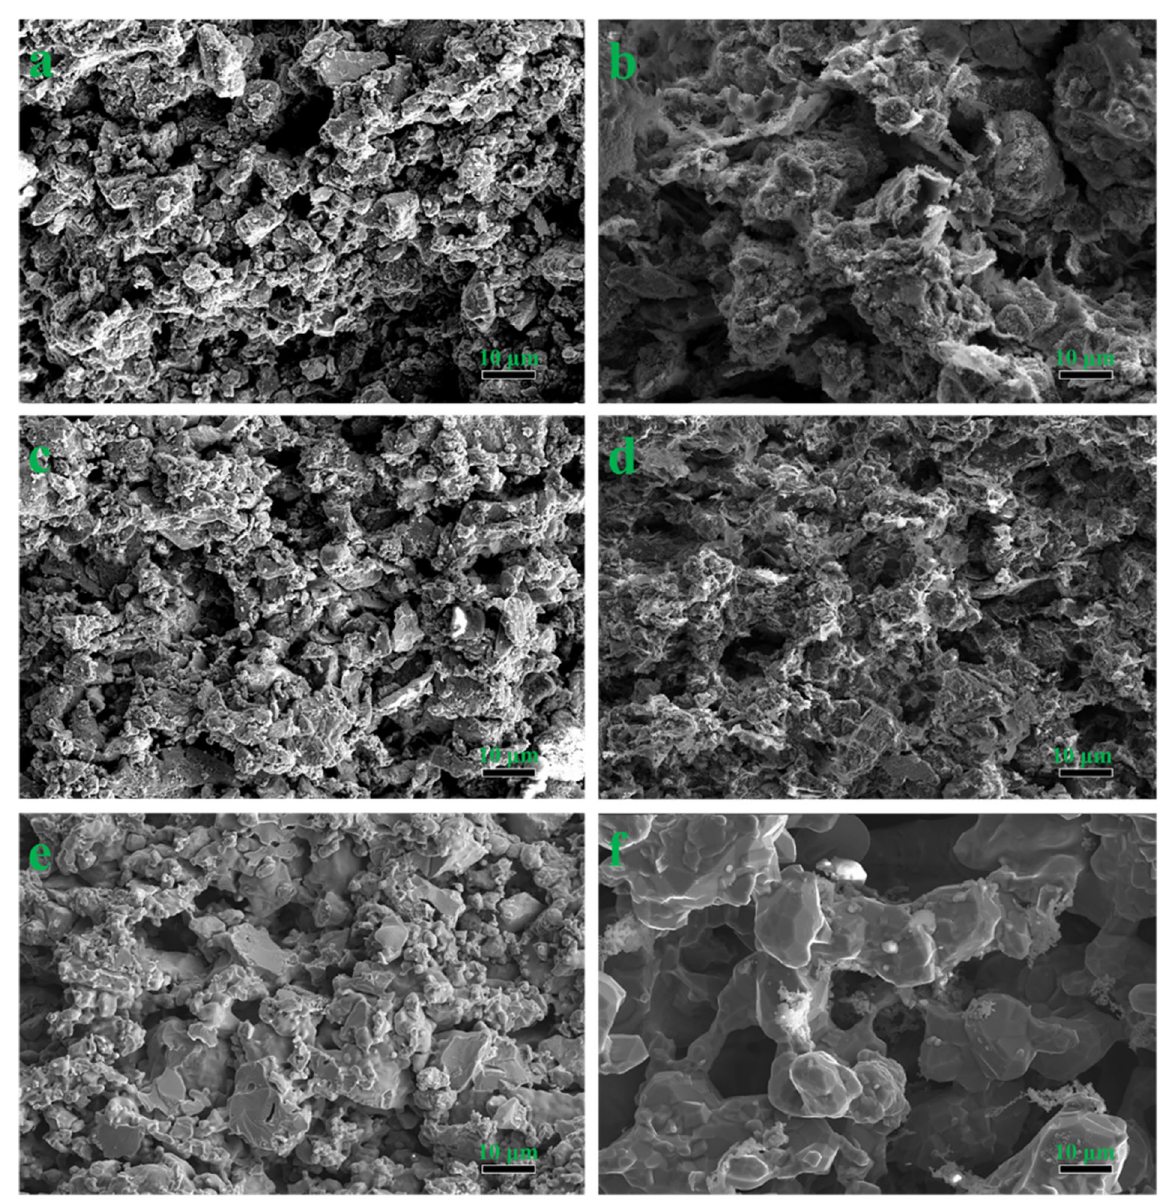
Fig. 4 Surface FESEM images of porous sample. Ti-48Al-6Nb porous alloy at various heat-treatment temperatures: a 600 °C, c 900 °C, e 1350 °C; PCMM at various heat-treatment temperatures: b 600 °C, d 900 °C, f 1350